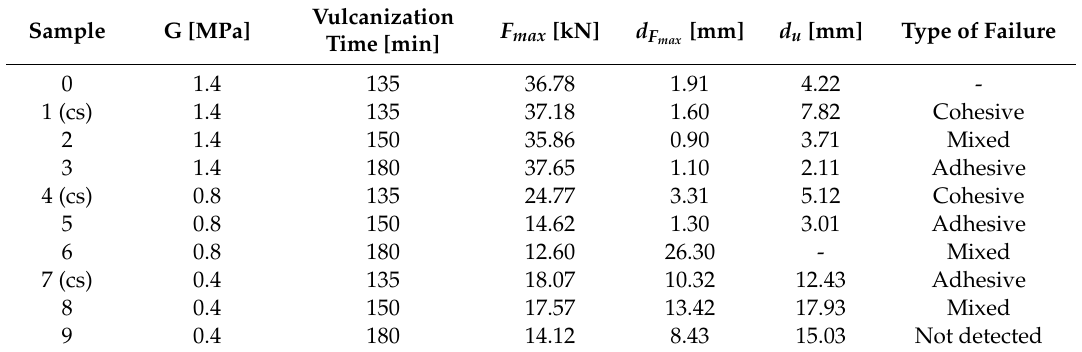
Table 2. Experimental results for samples 1 to 9.